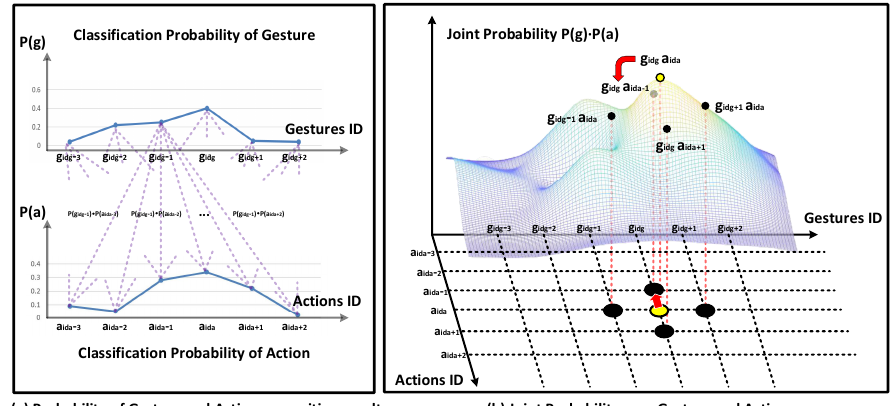
Figure 17. Illustration of the cross validation process. ( a ) shows the probability distribution of action and gesture recognition results. ( b ) shows how our cross validation process could correct the erros in ( a ). Here, the yellow point represent the wrong coding combination when either action or gesture recognition results is wrong. Block points refer to the correct coding that should be used to control UAV.